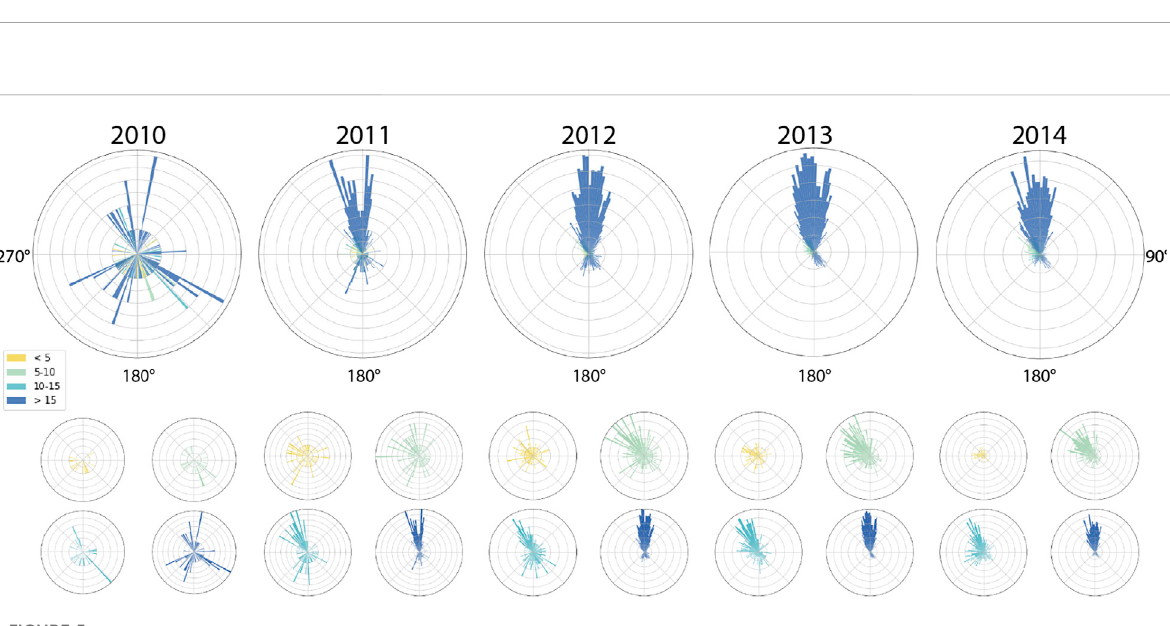
FIGURE 5 (A) Rotatedhistogramsforplumebendingazimuthswithmodelcurveshowing fi ttobimodalGaussian.Themodeldidnot fi ndasecondpeakin the 2014 data. (B) Combined model curves show the progressive decrease in size of the second peak, suggesting bottom current direction is increasingly in fl uenced by a background mean current that fl ows northwards (280 degrees off the depicted peak1 direction). (C) Plotting the peak locations (to get true direction, add 280 ° , and subtract 360 ° if necessary), peak amplitude, and peak widths suggests that the peak bending directions are consistent but the distribution between peak one and peak two shifts from balanced (equal amplitude) to dominantly peak one between 2010 and 2011. Peak two amplitude continues to decay into 2014 (when there is no longer any evidence of the secondary